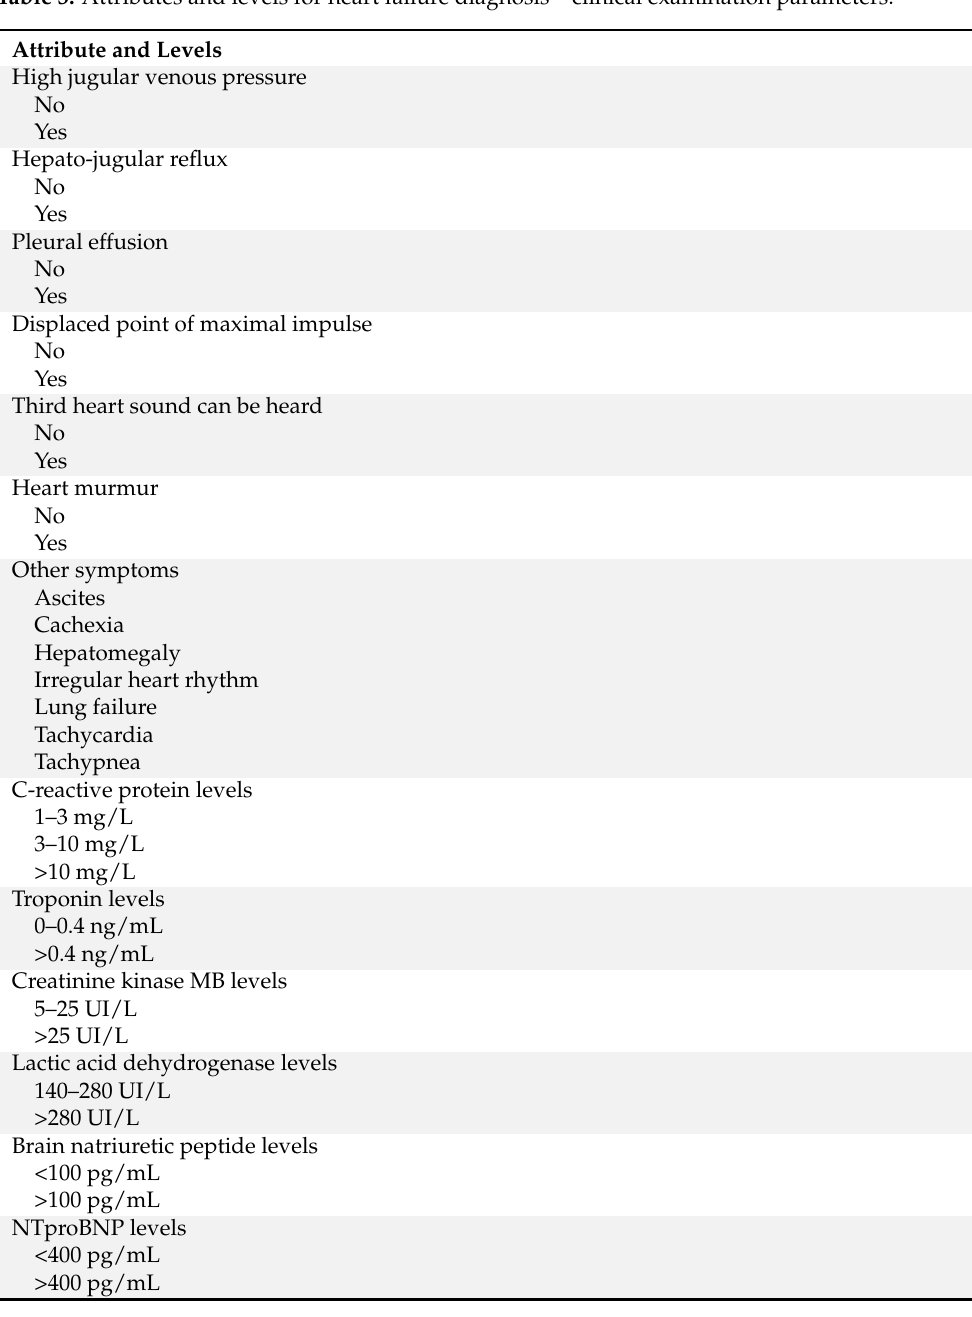
Table 3. Attributes and levels for heart failure diagnosis—clinical examination